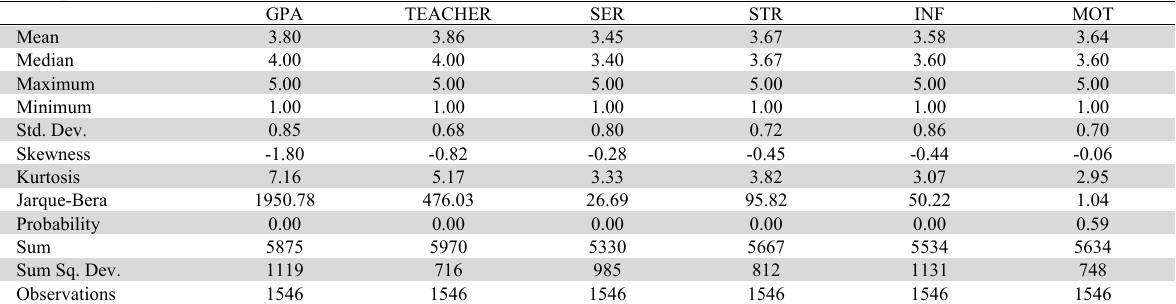
Descriptive analysis